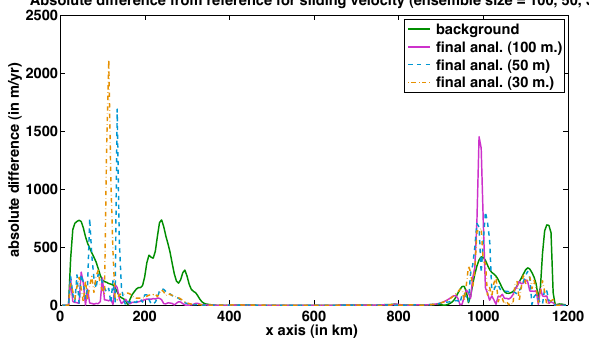
Fig. 19. Absolute difference between results and reference for the sliding component U slid of the surface velocity after 20 years of the LETKF with inflation. The background (green) is compared to the analyses for various ensemble sizes: 100 members (purple), 50 members (cyan), and 30 members (orange). RMS error evolution is synthesised in Table